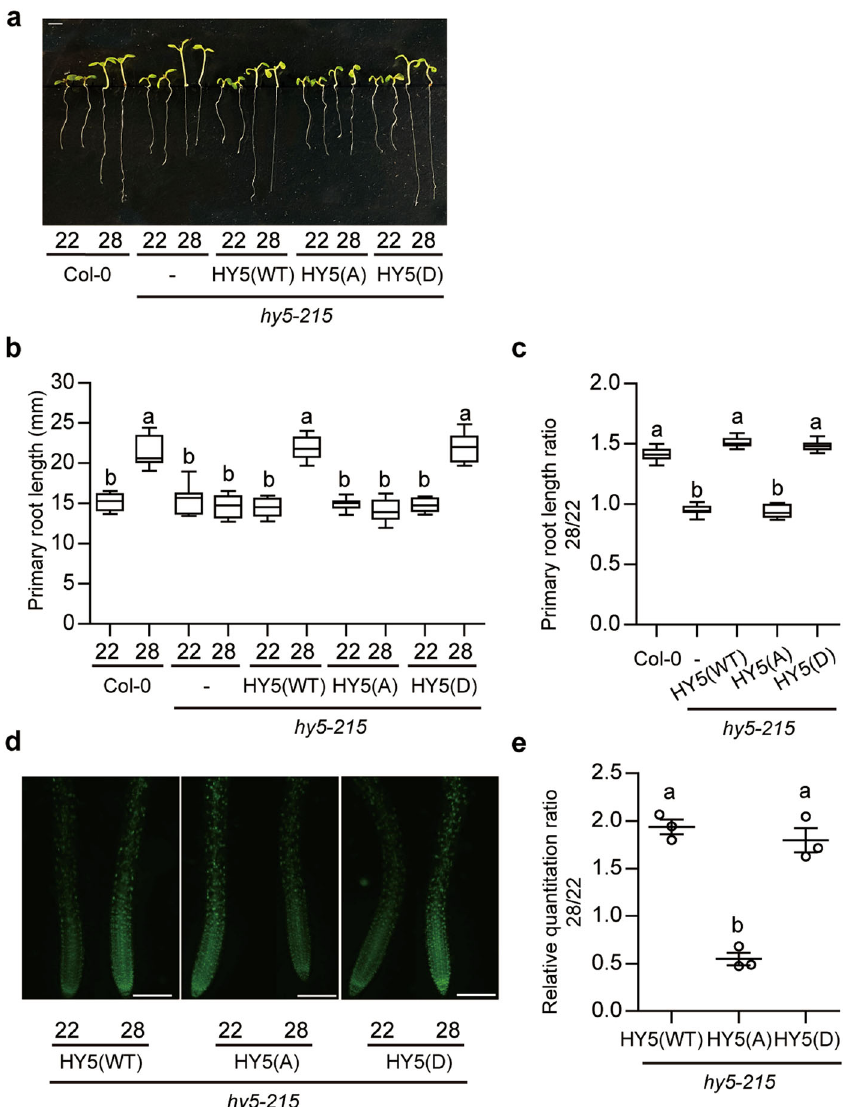
Fig. 4 Phosphorylation of HY5 is necessary for stabilization and root thermomorphogenesis. a Photograph showing seedling phenotypes of three different types of HY5 overexpression lines grown in 22 °C and 28 °C. Seedlings were grown for two days in continuous white light at 22 °C and then either kept at 22 °C or transferred to 28 °C for additional 4 days before being photographed. The scale bar represents 2 mm. b , c Bar graphs show the primary root lengths ( b ) or the root length ratio ( c ) for the seedlings grown under conditions described in ( c ). For the length ratio 28/22, the primary root length at 28 °C is divided by that at 22 °C. The letters a – c indicate statistically signi fi cant differences between means of primary root lengths ( n = 12, P < 0.05) based on one-way ANOVA analyses with Tukey ’ s HSD test. For the box and whisker plots in b , c , the boxes represent from the 25th to the 75th percentile and the bars equal the median values. The source data underlying the root measurements ( b , c ) are provided in the Source data fi le. d Fluorescence images of roots using three types of HY5-GFP overexpression lines with the same exposure time ( t = 300 ms). The scale bar represents 200 μ m. e Bar graph shows the relative amount of HY5-GFP signal at 28 °C divided by that at 22 °C with three repeats. Error bars indicate SD ( n = 3). The letters a, b indicate statistically signi fi cant differences between means of primary root lengths ( n = 3, P < 0.05) based on one-way ANOVA analyses with Tukey ’ s HSD